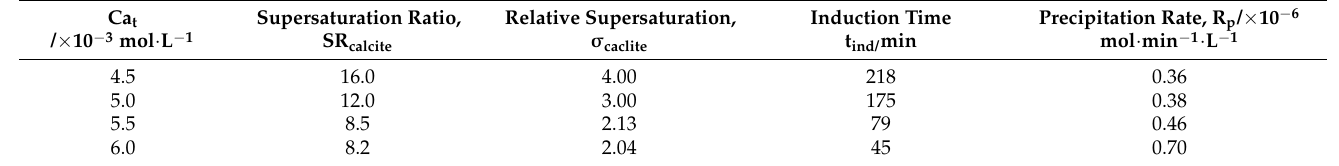
Table 4. Precipitation of calcium carbonate in the presence of 6.0 µ M of nickel under illumination and 20 mL of active A. obliquus culture (including nutrient medium). Calcium (total) concentration (=carbonate concentration), ratio of supersaturation, relative supersaturation, induction time, and precipitation rate of calcium carbonate; pH 8.50, 0.15 M of